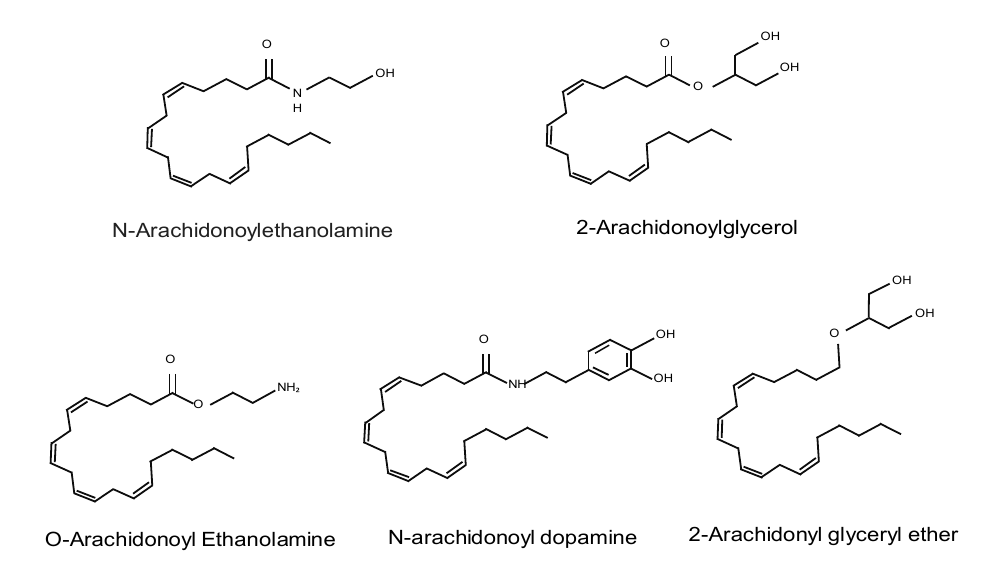
Figure 1. Chemical structures of endogenous cannabinoids: N -arachidonoylethanolamine (AEA, anandamide), 2-arachidonoylglycerol (2-AG), O -arachidonoyl-ethanolamine ( O -AEA,